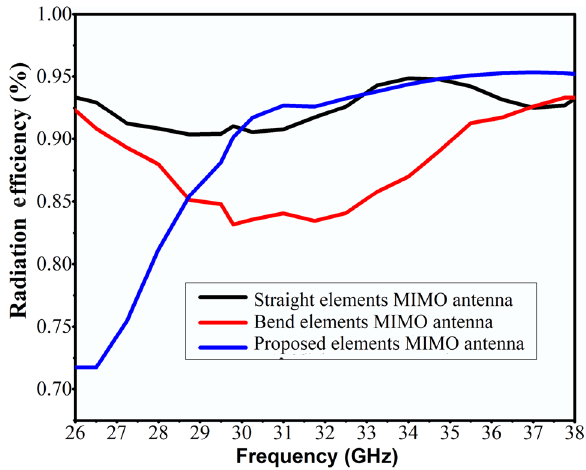
Figure 7. Simulated radiation efficiency of straight elements, bend elements, and proposed elements MIMO antenna.